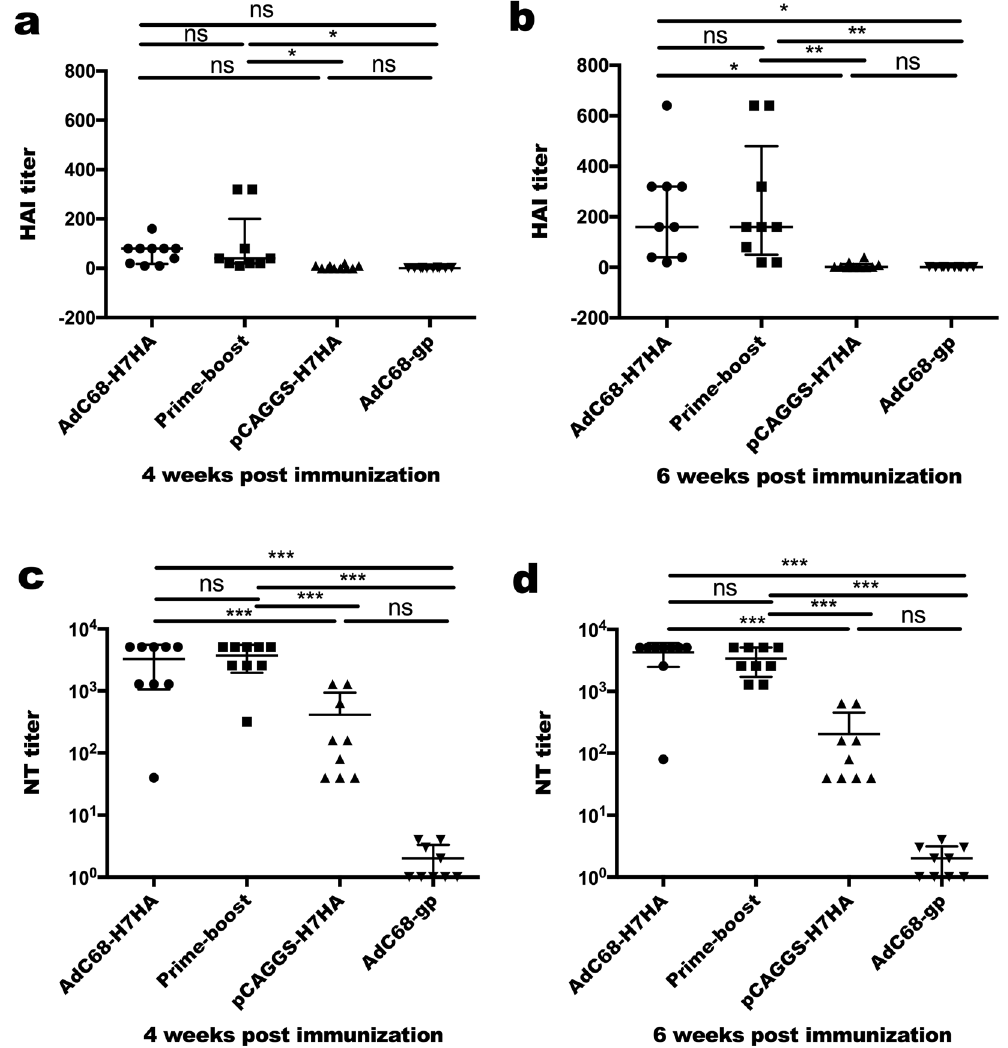
Figure 3. HAI and NT antibody titres of serum samples from immunized mice. C57BL/6 mice (8–10 animals/ group) were divided into 4 groups: AdC68-H7HA group, pCAGGS-H7HA group, AdC68-gp group, and the prime-boost group. Four and 6 weeks after the first immunization, HAI and NT titres were detected in the serum samples. ( a,b ) HAI antibody titres against H7N9. ( c,d ) NT antibody titres against H7N9 pseudovirus. The error bars represent the SD. *** p < 0.001; ** p < 0.01; * p < 0.05; ns, not